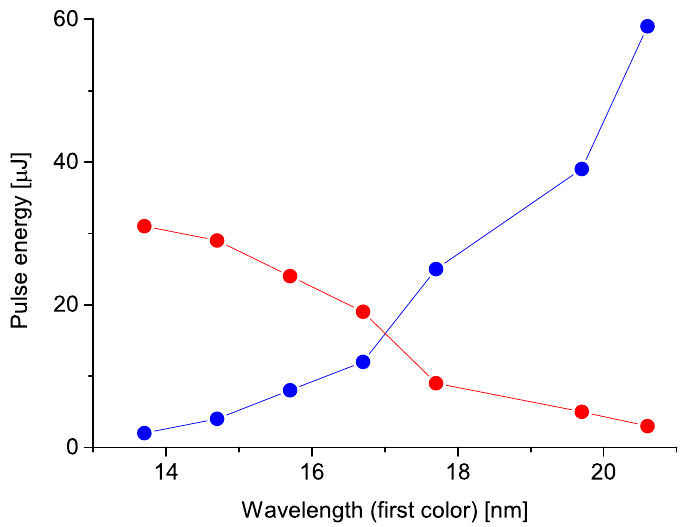
Figure 5. Pulse energies of two XUV beams measured with the GMD+OPIS method. The first color (odd undulator segments) is scanned between 13.7 nm and 20.6 nm (shown in blue). The second color (even segments) stays at 22.6 nm (shown in red).The figure was published in [17].